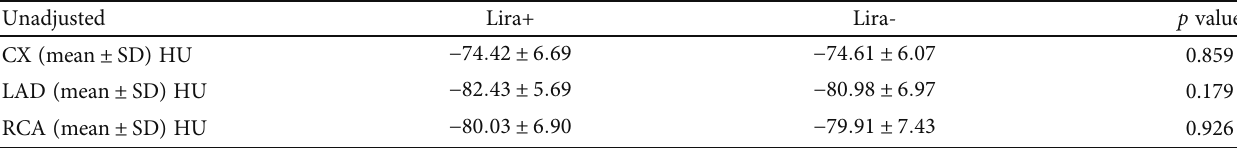
Table 2: Di ff erences in PCAT CCTA attenuation crude values between Lira+ and Lira- for each coronary artery. Unadjusted Lira+ Lira-